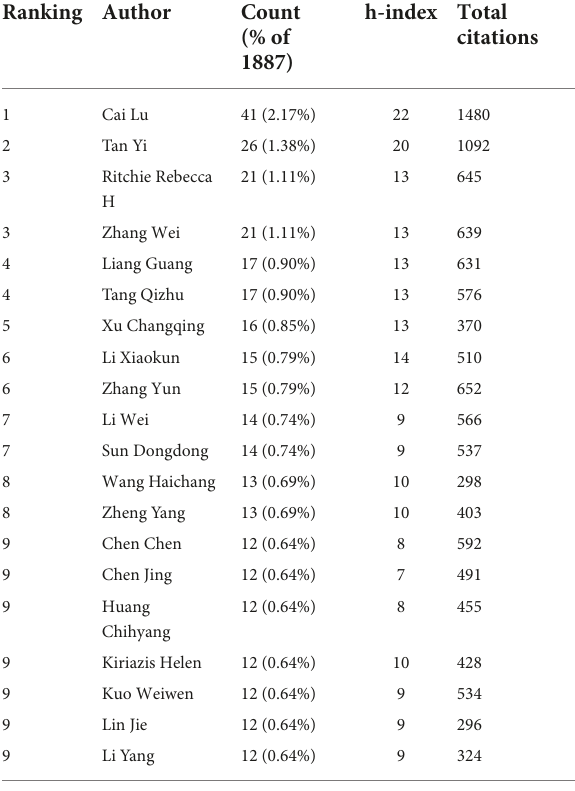
TABLE 2 Top 20 contributing authors of diabetic cardiomyopathy research in the past